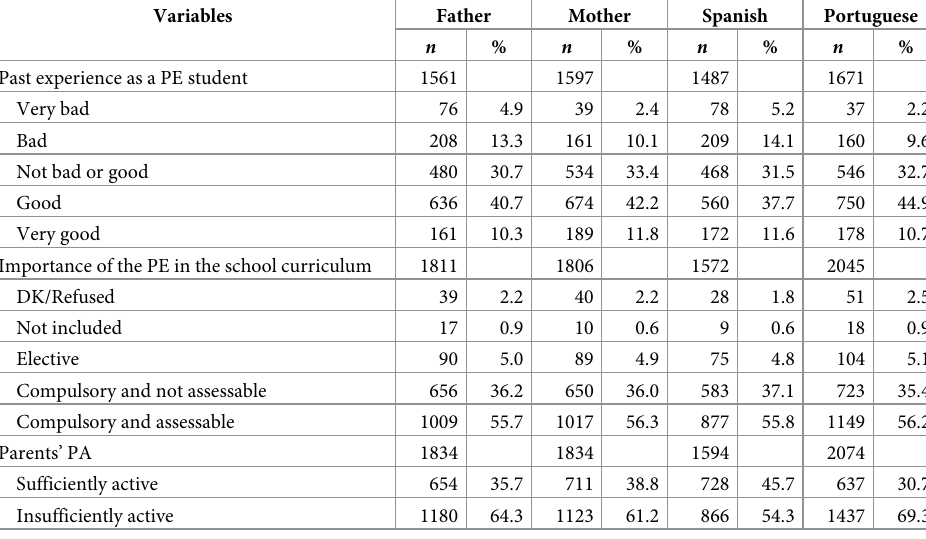
Table 2. Descriptive statistics of parental assessment and physical activity (N = 3668). Variables